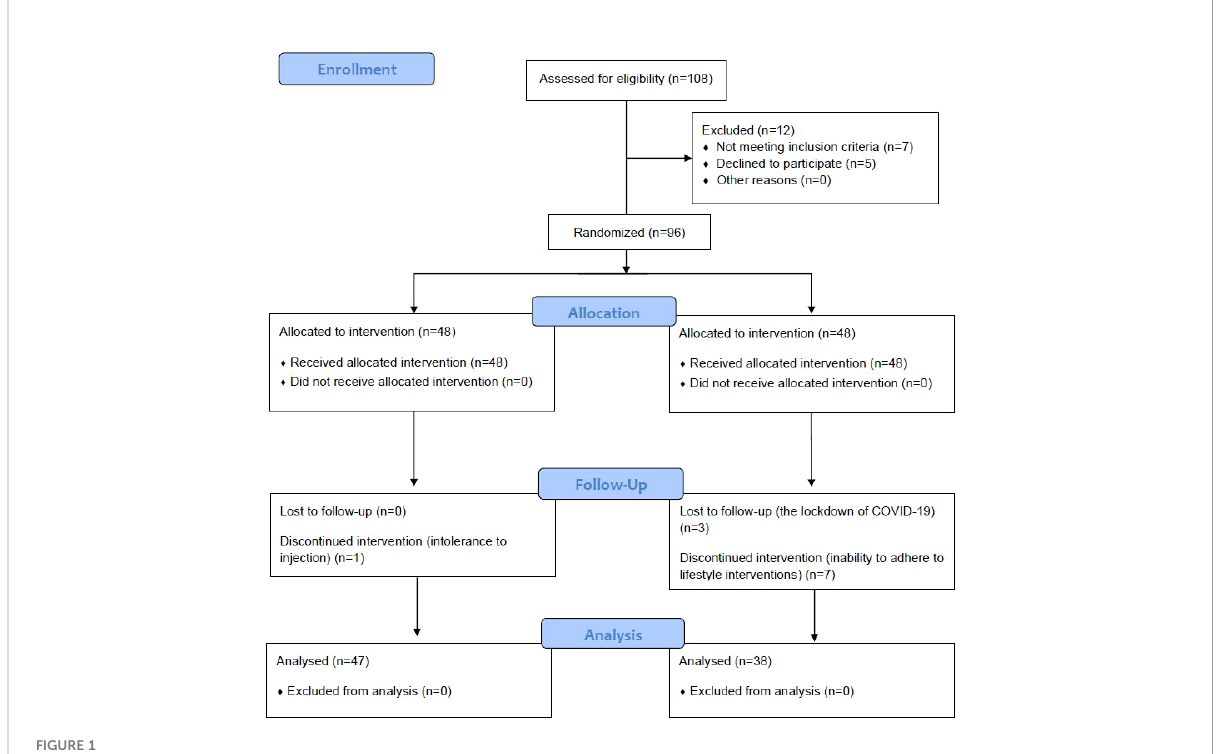
FIGURE 1 CONSORT Flow